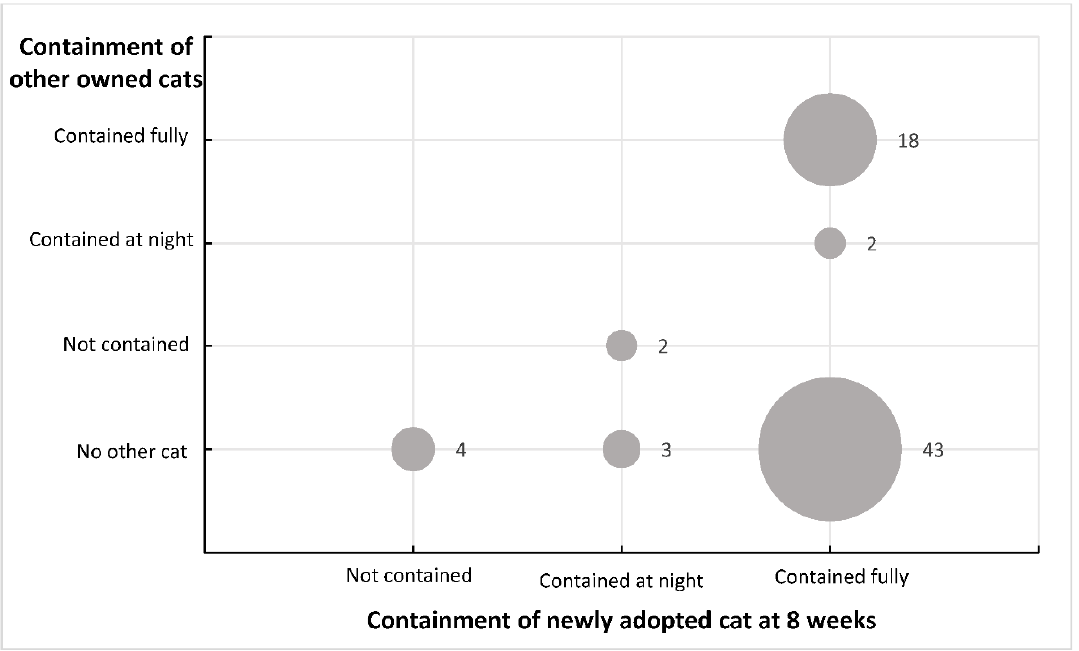
Figure 2. Summary of the containment behaviour for other owned cats (vertical axis), and the containment behaviour for the newly adopted cat after 8 weeks (horizontal axis). Size of dots represent number of participants.